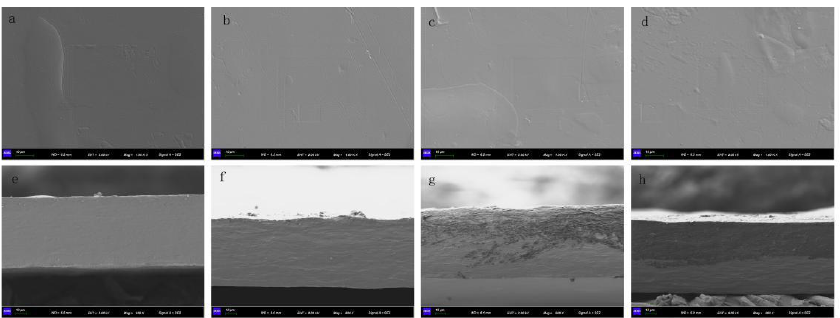
Figure 1. SEM micrographs of the surface and cross-section of films. ( a ) surface and ( e ) cross- section of CS/к C film; ( b ) surface and ( f ) cross- section of 1% CS/к C -GSE film; ( c ) surface and ( g ) cross- section of 3% CS/к C -GSE film; ( d ) surface and ( h ) cross- section of 5% CS/к C -GSE film. ( g ) cross-section of 3% CS/ κ C-GSE film; ( d ) surface and ( h ) cross-section of 5% CS/ κ C-GSE